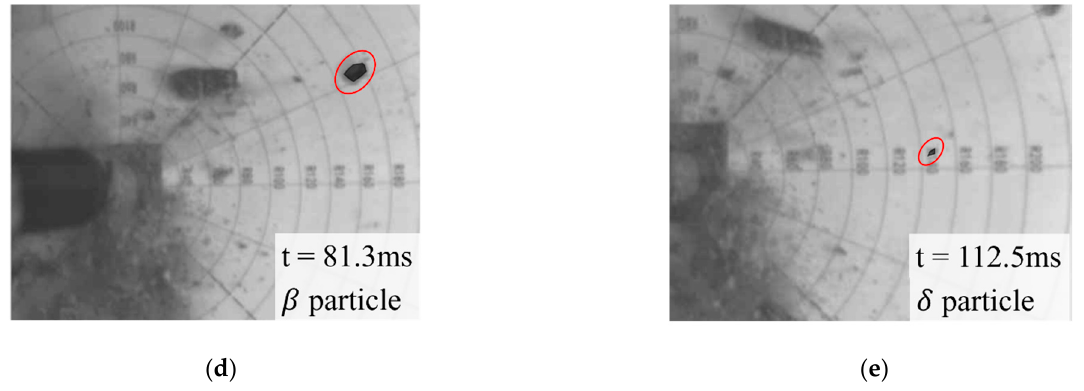
Figure 5. The temporal and spatial characteristics of the movement of fragments particles. ( a ) High-speed camera images in time series ( b – e ) The enlarged view of the four types of particles. Table 2. Temporal and spatial position and movement characteristics of fragments particles.